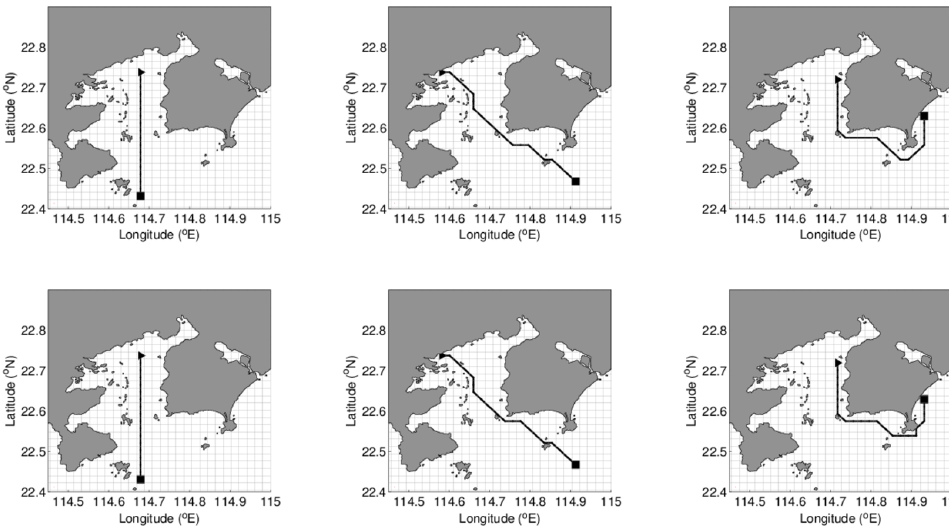
Figure 8. Same as Figure 7, but the AUV moves along the ocean current.